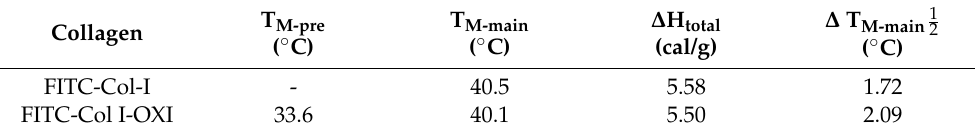
)—obtained from DSC profiles of FITC-Col I and FITC- 2